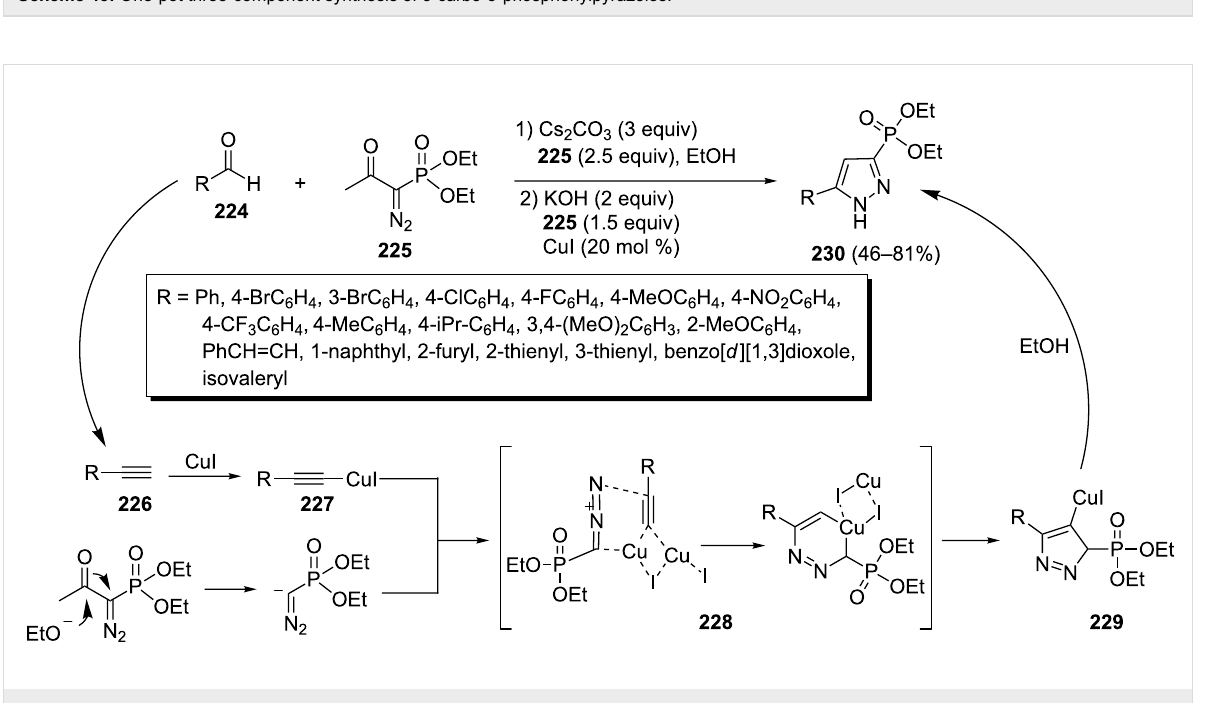
synthesis of (5-vinylpyrazolyl)phosphonates 234 from α , β